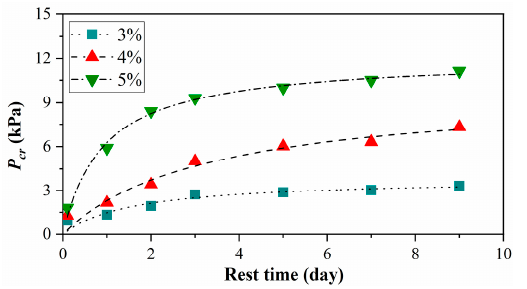
Figure 6. Relationship between cracking pressure and rest time. The cracking pressure P cr is adopted to reflect the strength prosperity of MLPS transparent soils. The figure shows that the strength increase with the increasing concentrationas well as the rest time. Curve with 5% shows a more strongly increase than curves with 4% and 3%. All curves reach stable stages after enough rest time.